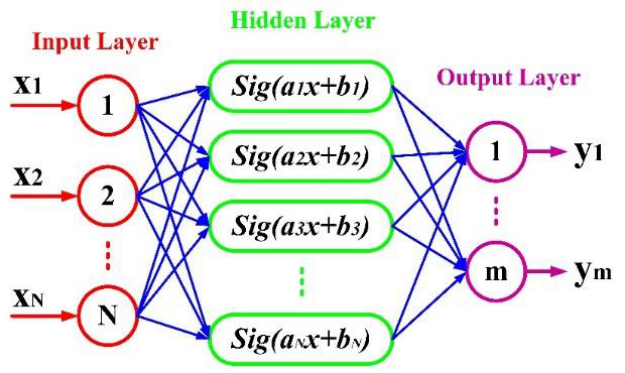
Figure 2. The architecture of the ELM.